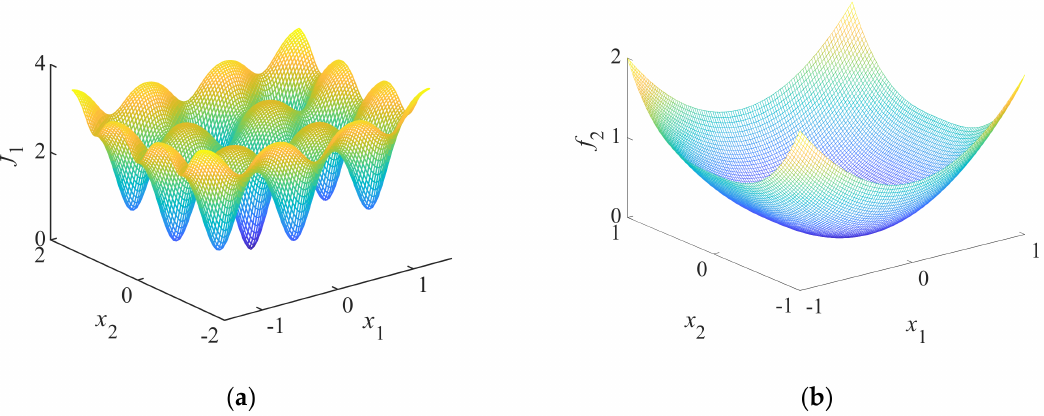
Figure 2. Image of the benchmark functions: ( a ) Ackley’s path function; and ( b ) the sum of different power